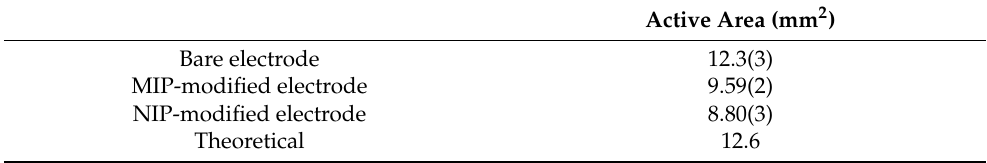
Table 5. Active areas calculated by Randles–Sevick’s equation (average of the values obtained by plotting the anodic and the cathodic peak of the CV vs. the square root of the scan rate.